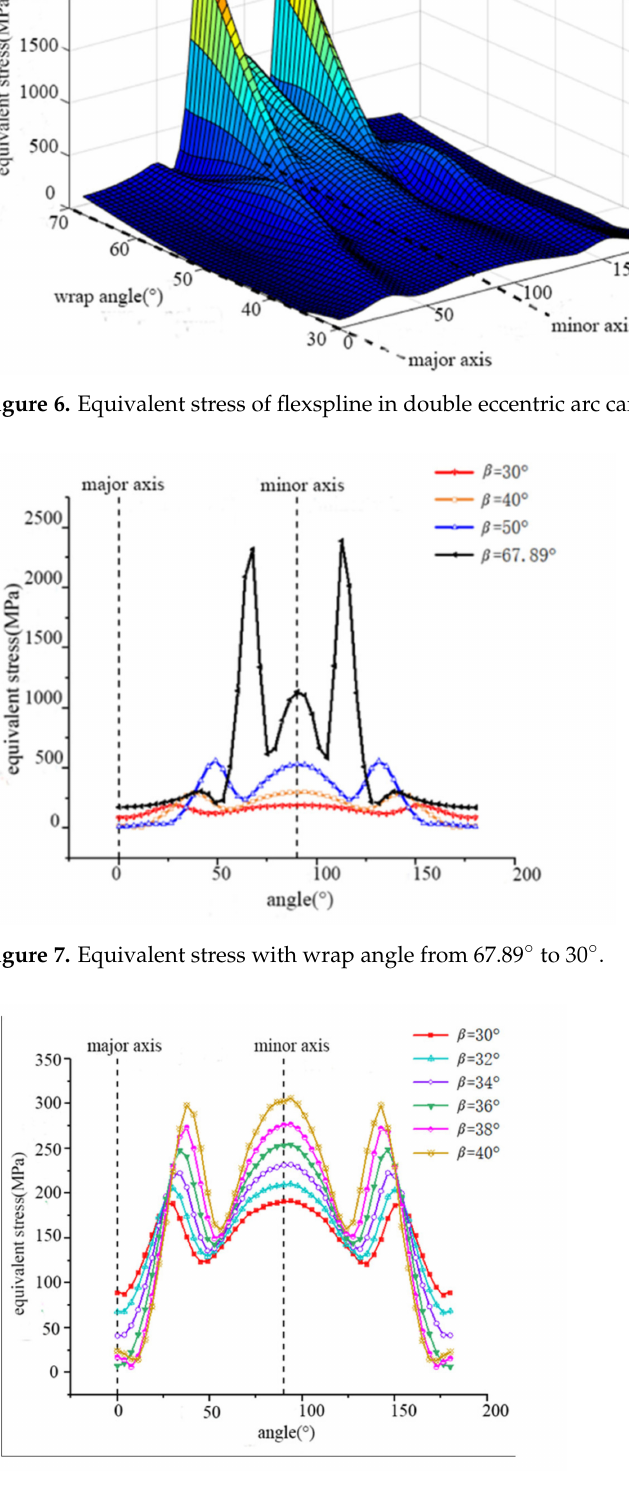
Figure 8. Equivalent stress with wrap angle from 30 ◦ to 40 ◦